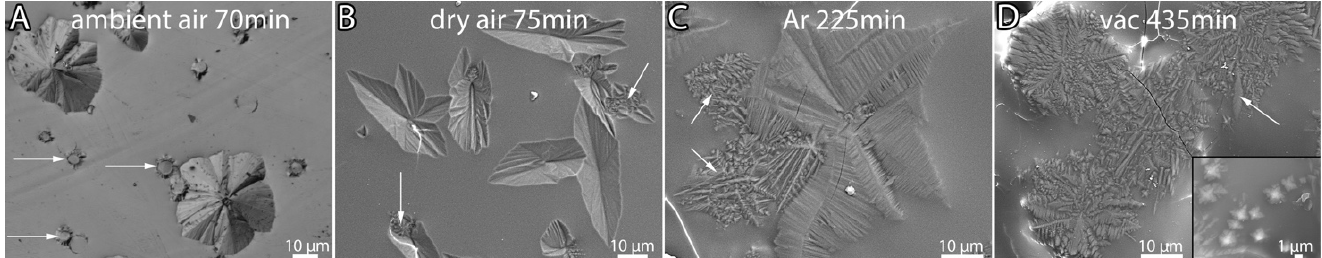
Figure 1. SEM images of freshly fractured glass surfaces heat-treated in different atmospheres. ( A ) Ambient air: compact crystal arrangements and small circular structures (arrows). ( B ) Dry air: spear- head-shaped compact crystals and small dendritic crystals (arrows). ( C ) Argon: platy aggregates of straight to curved central lines with ramifications accompanied by dendritic crystals (arrows). ( D ) Vacuum: radially arranged dendrites and few needle-like crystals (arrow). The zoom-in shows a second generation of small crystals (bimodal distribution).